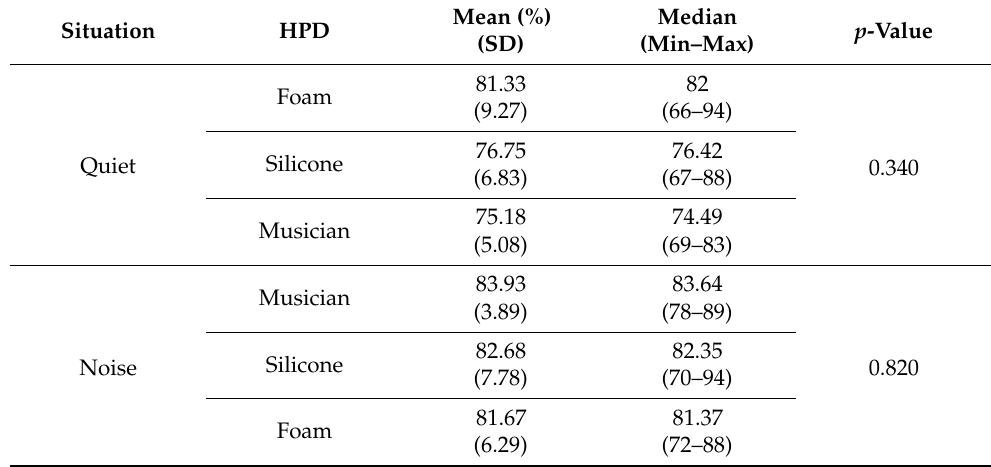
Table A4. Percentage of correct words from sentences in quiet and noise with and without HPD.